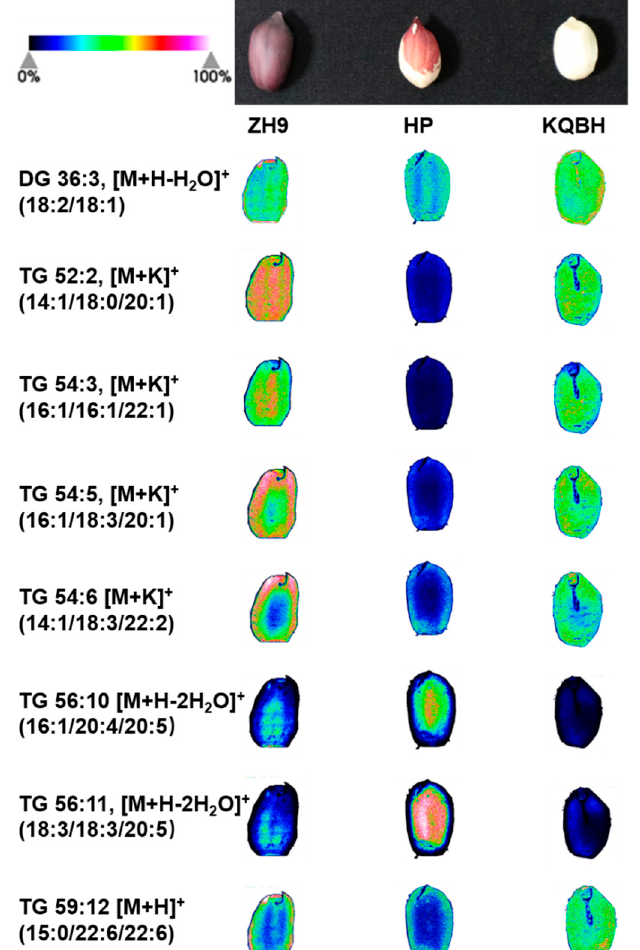
Figure 5. MALDI-MSI of representative glycerolipids in different peanut seeds. The left column shows the name of triacylglycerols (TGs) and diacylglycerol (DG). The green (minimum) to red (maximum) scale indicates ion intensity corresponding to each lipid species determined by mass spectrometry. For the same lipid individuals, signal range was normalized at the same level.